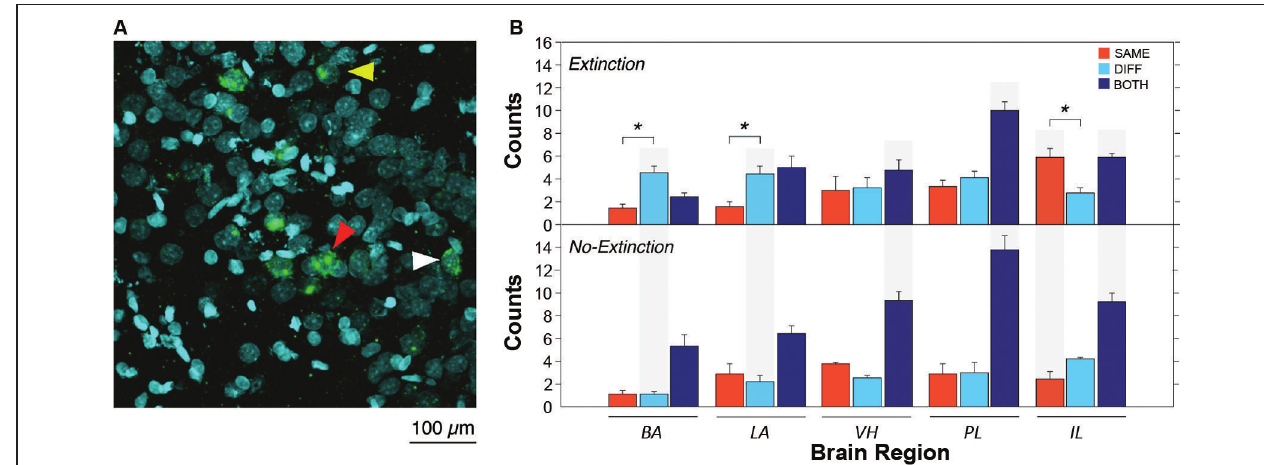
FIGURE 2 | Representative catFISH staining and subsequent cell count results. (A) Representative confocal images VH taken at 40X magnification. White arrowheads indicate cytoplasmic staining and yellow arrowheads indicate nuclear staining. Red arrowheads indicate nuclear and cytoplasmic staining (non-selective neurons). (B) Raw counts of cells expressing Arc after in the extinction context (SAME), the renewal context (DIFF) or both contexts (BOTH). For the no-extinction group (NO-EXT), SAME and DIFF refer to the matched physical contexts